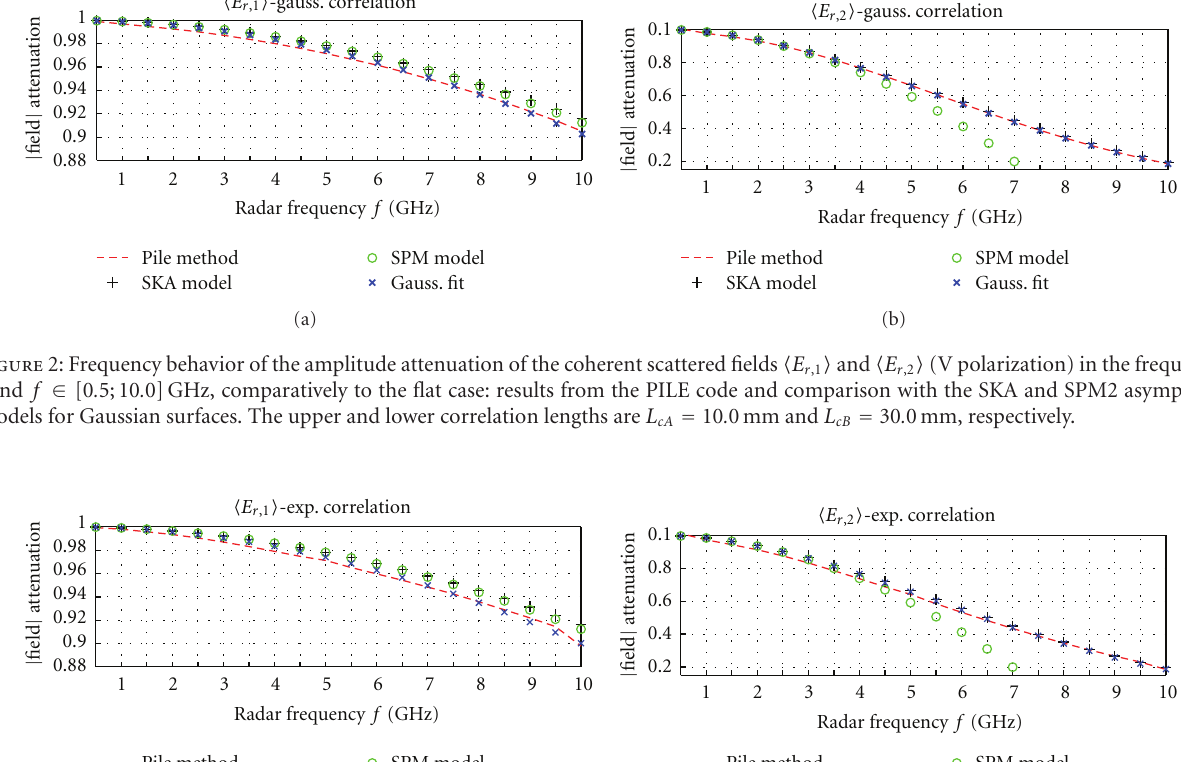
surface Σ B , the RMS height σ h B and the correlation